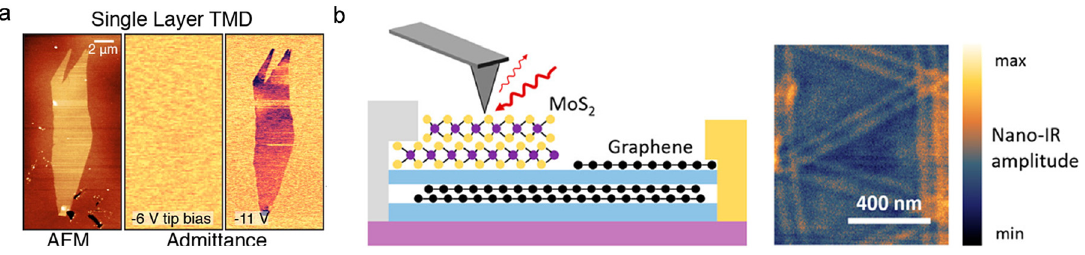
Figure 13: Applications of near-field imaging of 2D-TMDs. (a)AFMimageandmicrowavenear-fieldimagesof1L-MoS 2 with − 6Vand − 11Vtipbias.Reproducedwithpermissionfromref.[150].Copyright 2015, Nature Publishing Group. (b) Schematic of MoS 2 -gated 1L-graphene device (left) and near- fi eld-infrared amplitude image (right). Reproduced with permission from ref. [153]. Copyright 2021, Nature Publishing